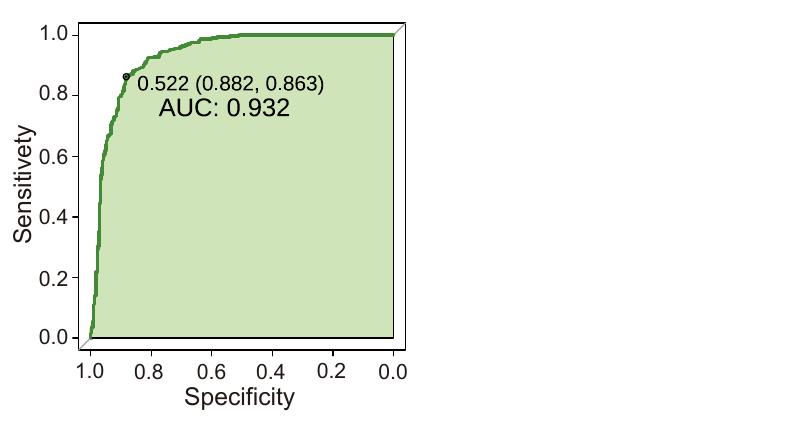
Figure 7. The ROC curve of the RF prediction model. The predictive effect of the eight-indicator prediction model can be quantified by AUC to evaluate the efficiency of the model